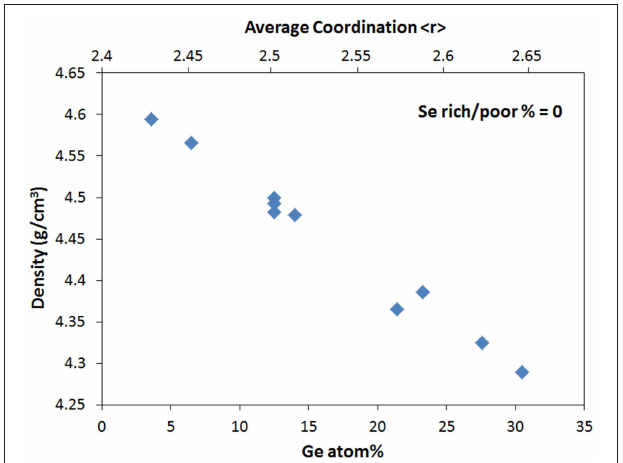
FIGURE 2 | Density of Ge-As-Se glasses with stoichiometric composition (Se rich/poor = 0) as a function of percentage of Ge atoms and average coordination < r > . The density varies linearly with Ge% when the effect of stoichiometry is neutralized.